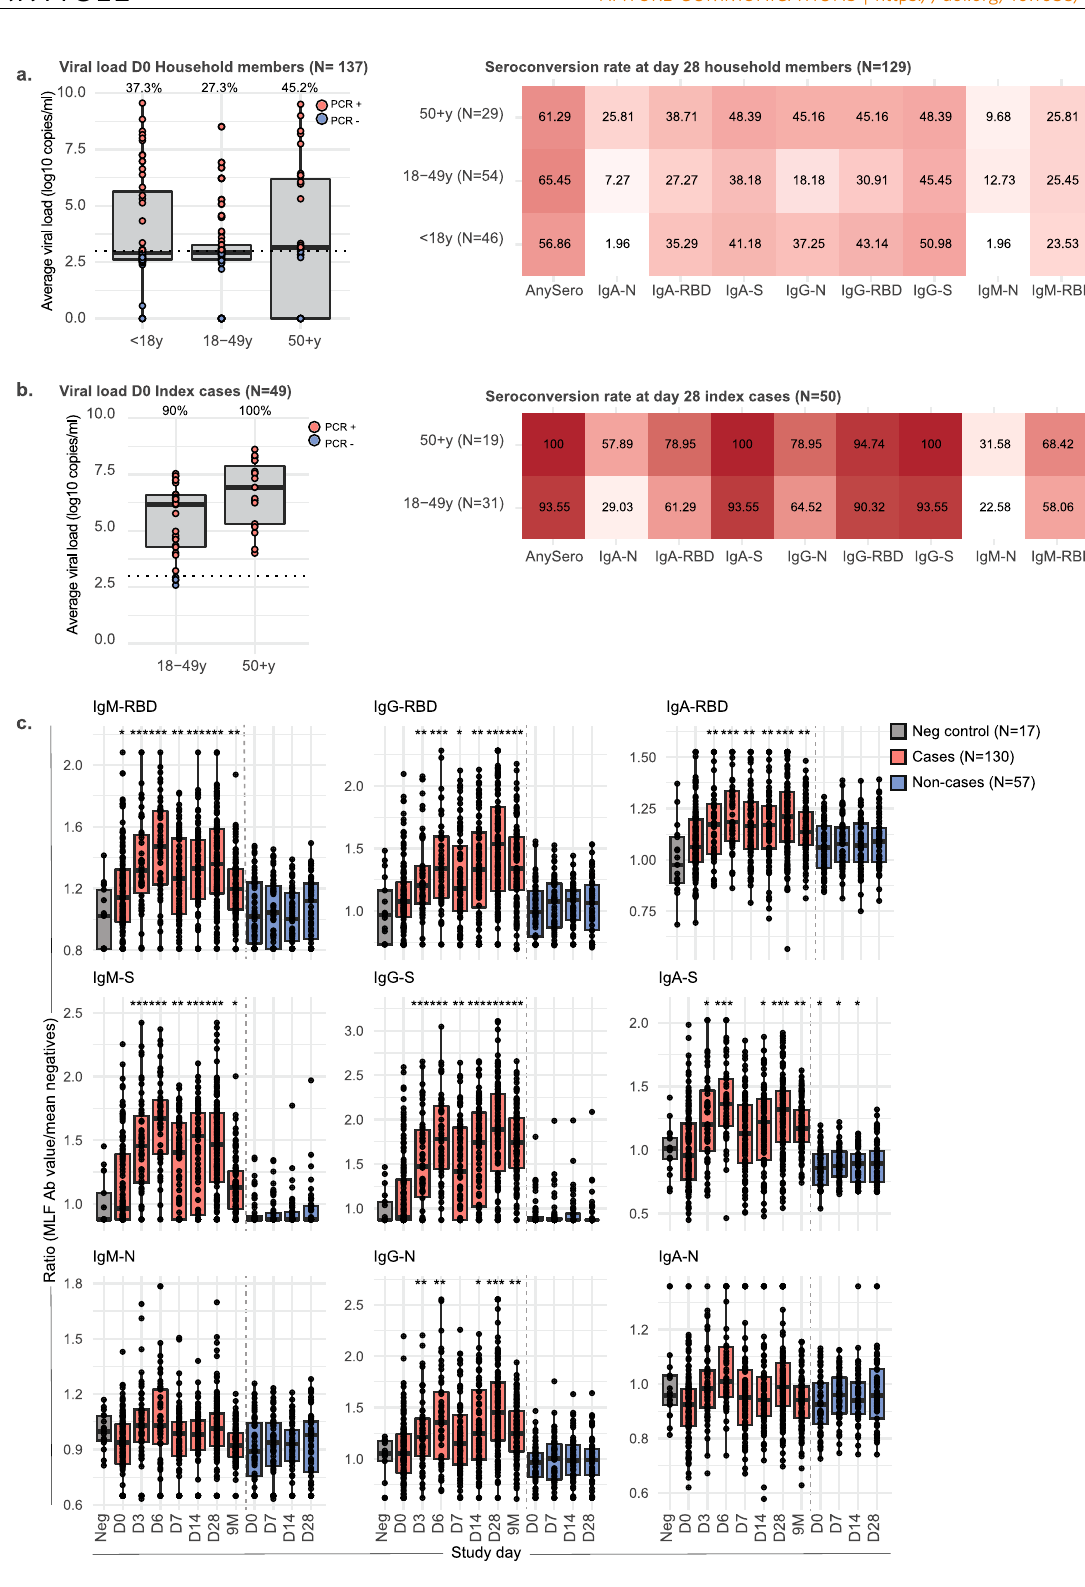
seroconversion against N (Fig. 2a). Of the index cases, 94% was still PCR positive at study start (Fig. 2b). Of the index cases, 92% had ‘ nasoconverted ’ by day 28, most of whom were PCR + and sero + (Supplementary Table S2). Similar to the contact cases, seropositivity rates were highest for S and lowest for N. IgG and IgA seropositivity rates were generally higher than IgM (Fig. 2b).